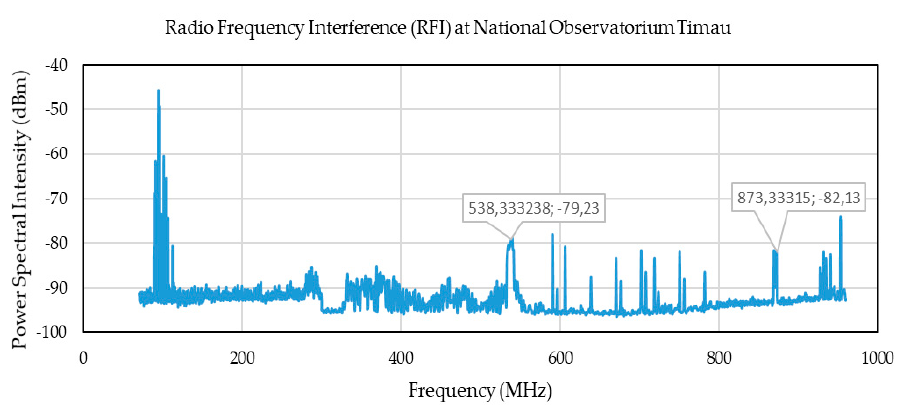
Figure 11. Recent measurements at frequencies 70–1000 MHz.